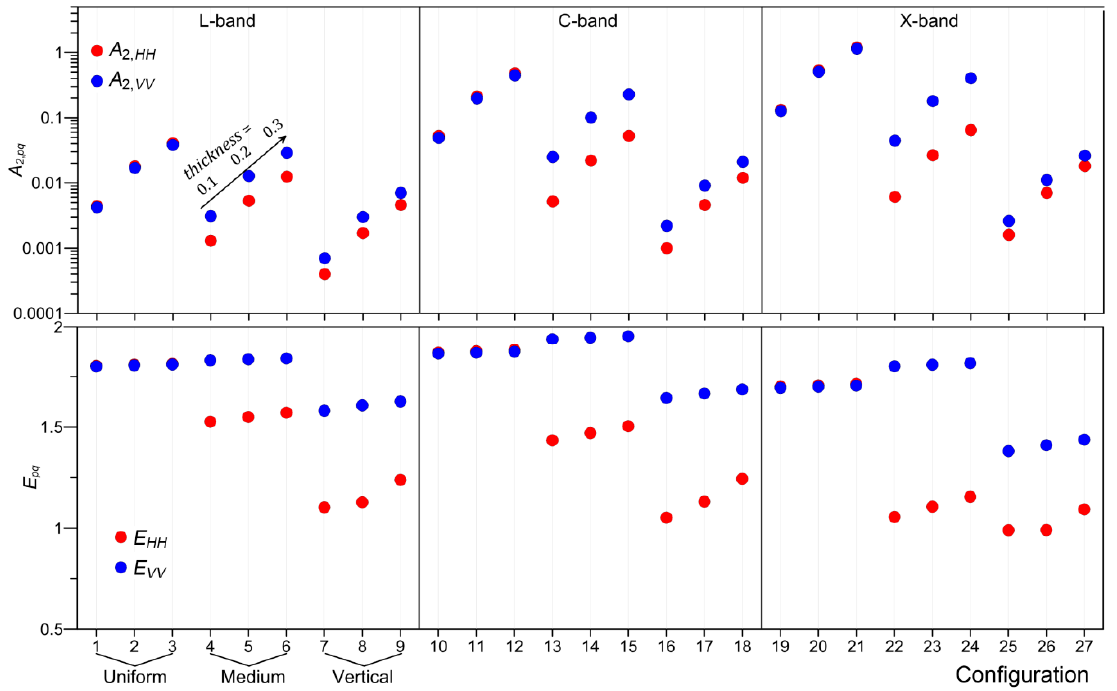
Figure 10. Variations of the A 2, pq and E pq parameters estimated for di ff erent environmental and observation configurations.